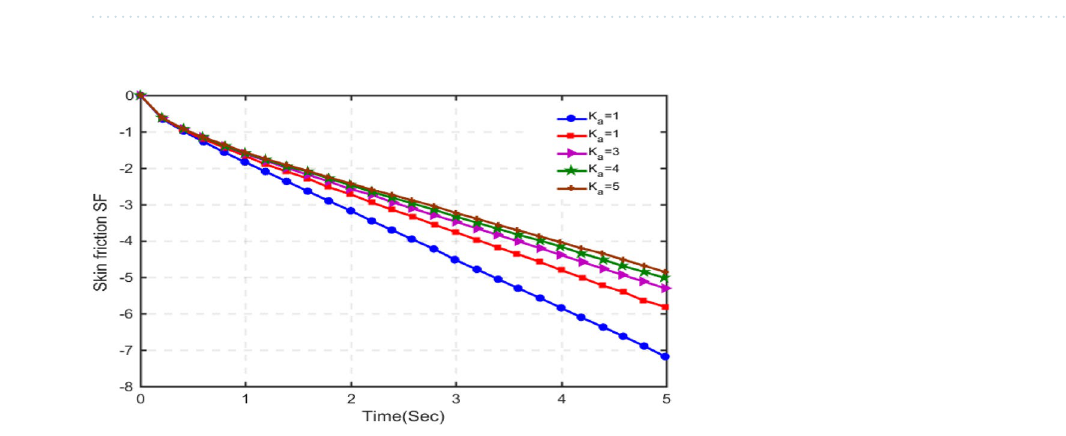
Figure 15. Variation in Bejan number for diverse values of Gr .